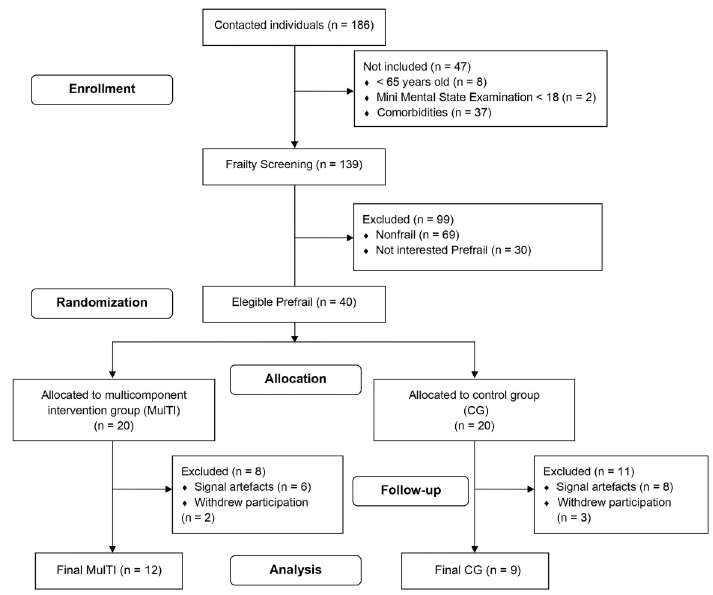
Figure 1. Flowchart of the fi nal